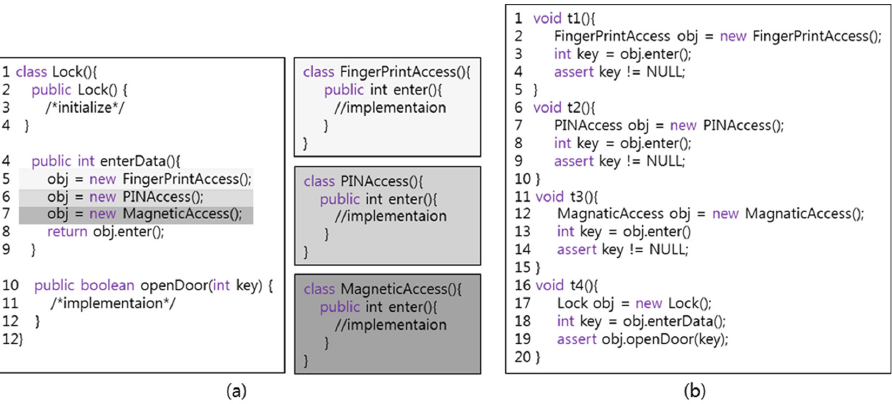
Figure 1. An illustrative example using the DoorLock SPL. ( a ) product line code base. ( b ) test cases